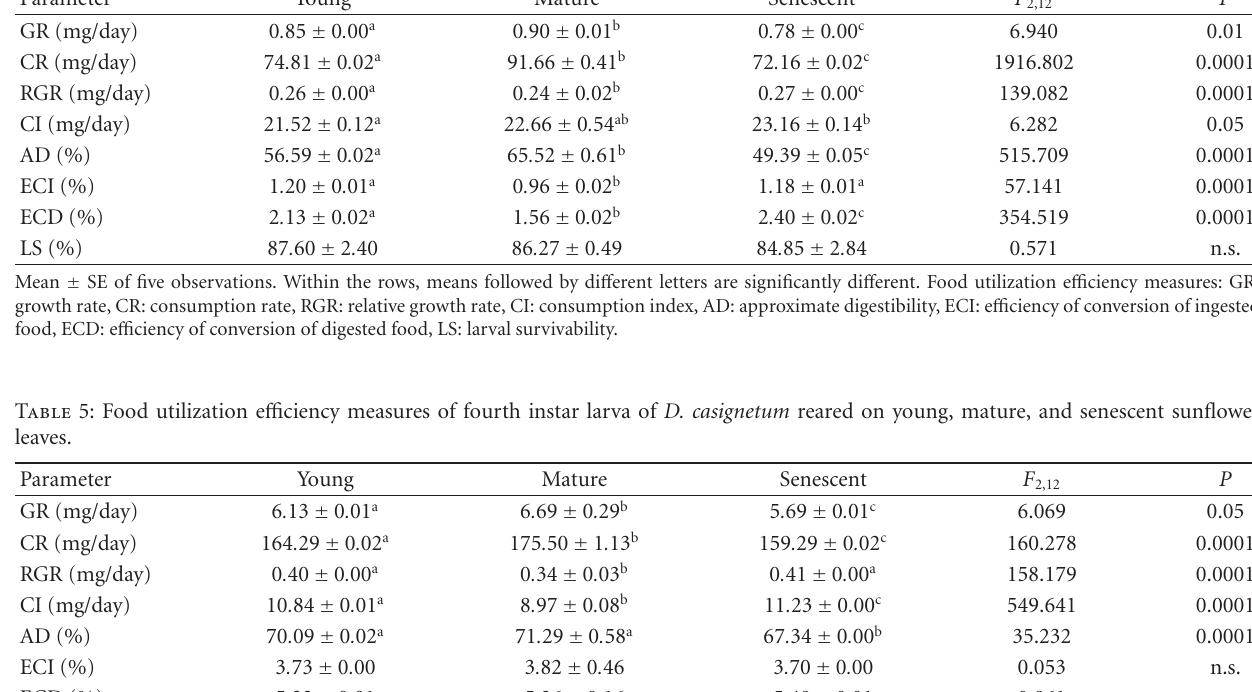
Table 4: Food utilization e ffi ciency measures of third instar larva of D. casignetum reared on young, mature, and senescent sunflower leaves. Parameter